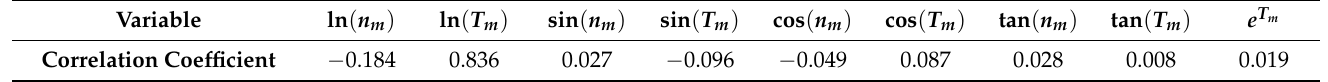
Table 7. Correlation coefficients of measured motor efficiency with multiple